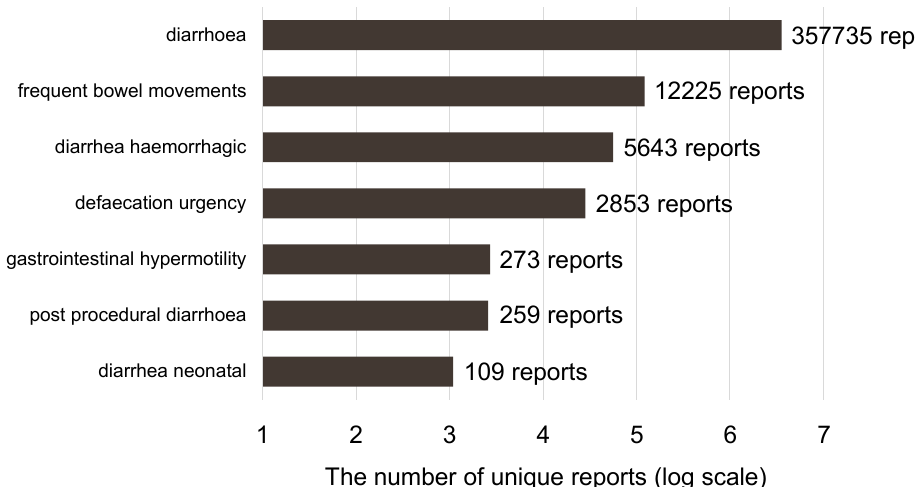
Figure 2. The number of unique records with preferred terms related to diarrhea, according to the narrow scope of Standardized MeDRA Queries.